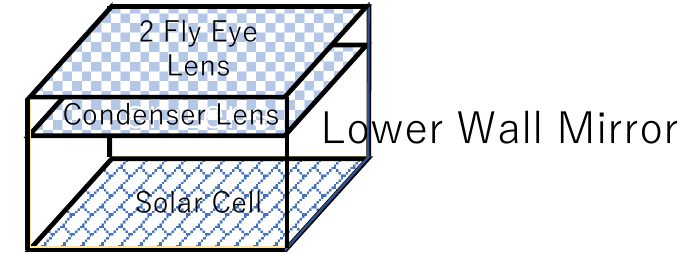
Figure 13. Fly Eye Module with Lower Wall Mirror.